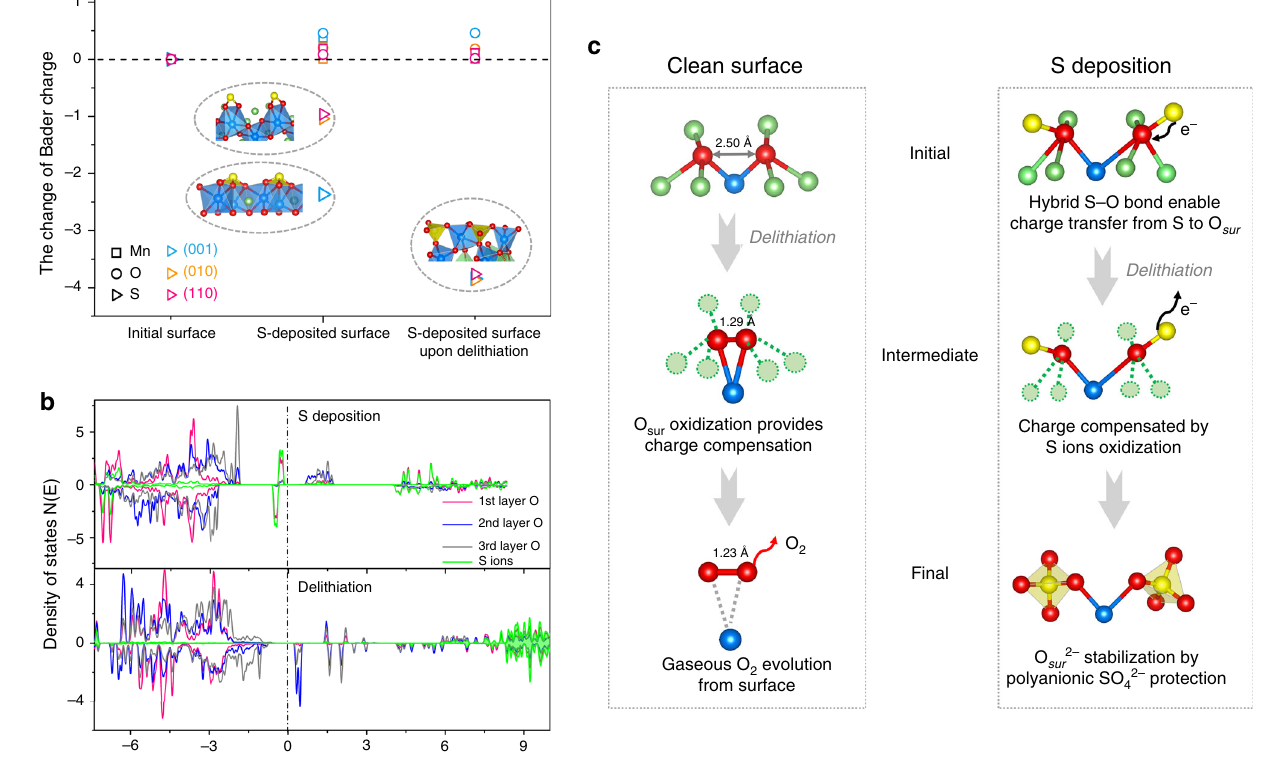
Fig. 4 Surface charge transfer of sulfur-deposited Li 2 MnO 3 and the mechanism of surface O stabilization. a The change in Bader charge of surface Mn, O, and S (per atom) on the three outermost surfaces during the process of S deposition and latter extraction of 37.5% Li. Bader charge of surface Mn, O (per atom) on the initial surface, and S atoms has been normalized to zero. b Calculated local density of states of the fi rst layer O to the third layer O and S ions upon S deposition and 37.5% delithiation. Here the (010) surface was taken as characteristic of the three surfaces of Li 2 MnO 3 . c Schematic of how S deposition stabilizes surface O during delithiation in the fi rst cycle (right), by contrast to O 2 evolution from the clean surface (left). From top to bottom: the coordination environment of the surface O ions pairs in full lithiation; the intermediate local structure after 37.5% delithiation; the fi nal stable con fi guration of surface O ions pairs after 37.5%